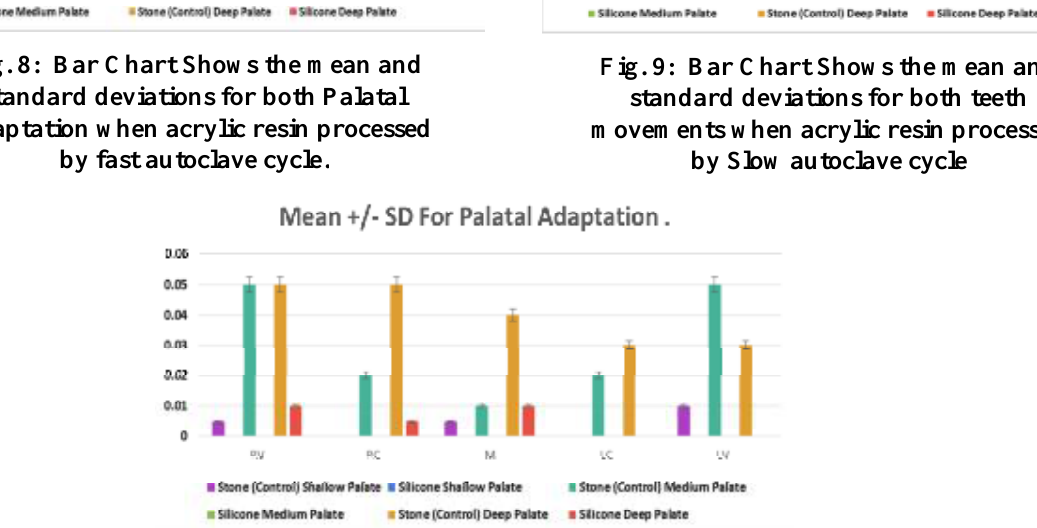
Fig. 10: Bar Chart Shows the mean and standard deviations for both Palatal Adaptation when acrylic resin processed by Slow autoclave cycle.